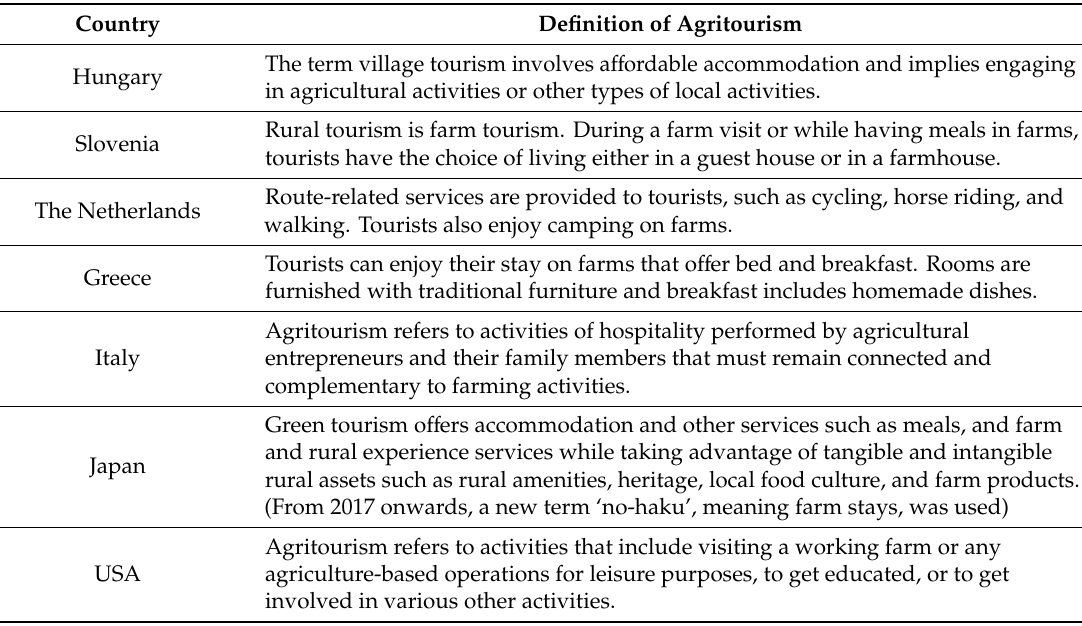
Table 1. Agritourism definition in di ff erent